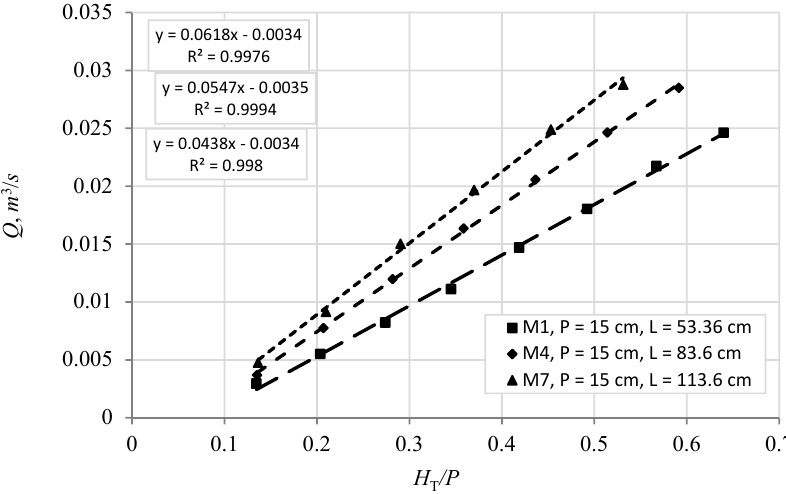
Figure 17. Total discharge, Q, vs. H T /P for models M1, M4, and M7.